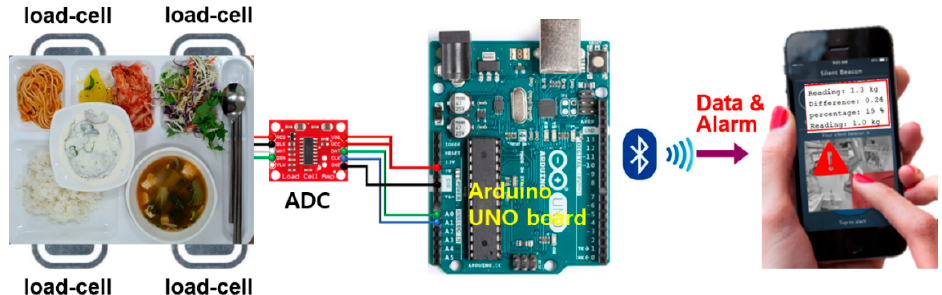
Figure 2. Conceptual architecture of a meal weight monitoring system.